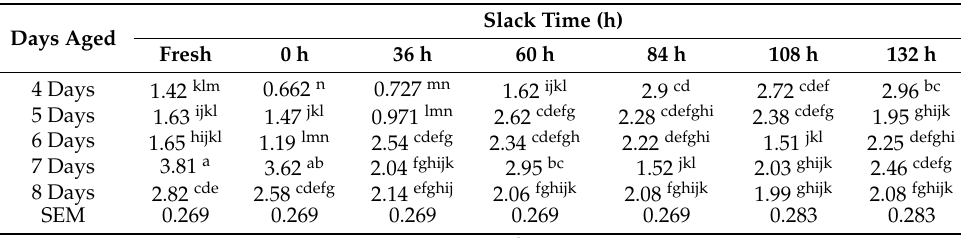
Table 1. Interactive impact (days aged 1 × slack time 2 ) on aerobic plate count values 3 of the chicken tenderloins during simulated food service